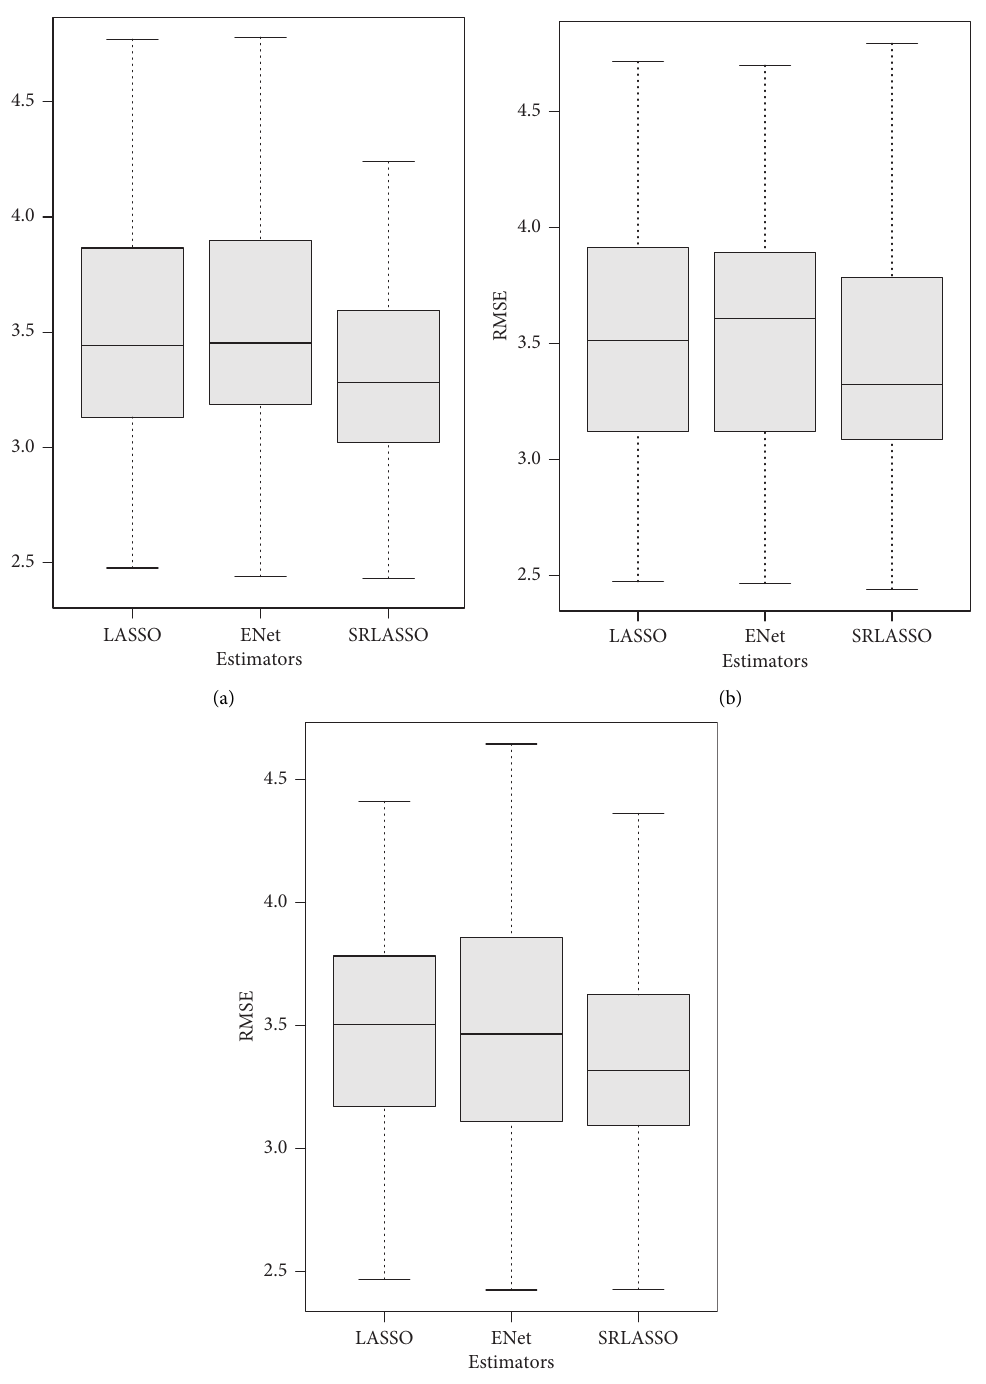
Figure 1: Cross-validated RMSE values of the estimators when (a) ρ � 0.5, (b) ρ � 0.7, and (c) ρ �